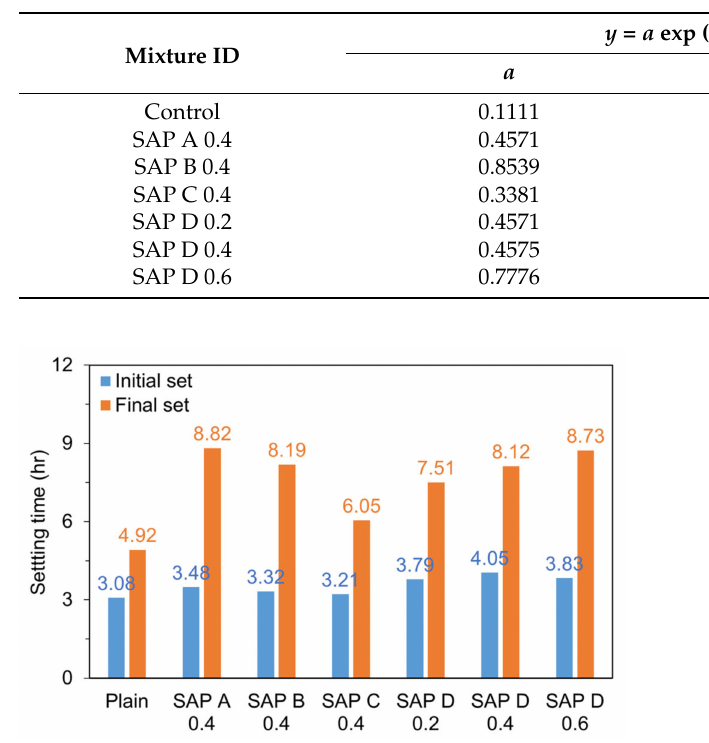
Figure 10. Initial and final set times for each mixture estimated based on fitting